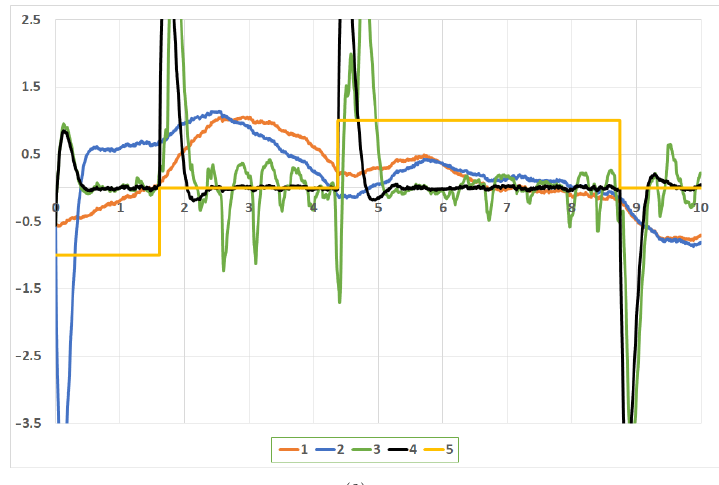
Figure 6. Actuator velocity: 1 − v